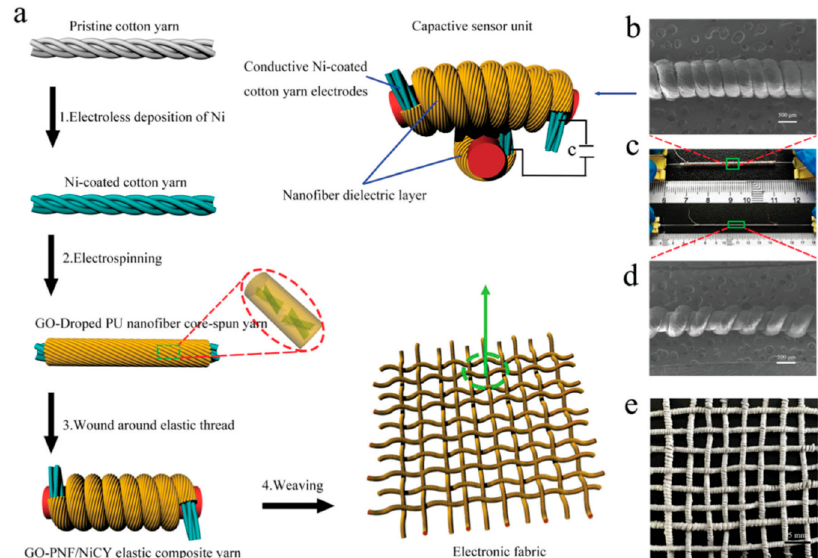
Figure 6. ( a ) Schematic demonstrating the use of yarns for developing electronic fabrics. Briefly, graphene doped polyurethane fibers are deposited on the surface of Ni-coated cotton yarns. These core-shell yarns are then wound around an elastic thread. In the next step, the composite yarns are woven to obtain a fabric. ( b ) SEM image of the elastic composite yarn. ( c ) optical microscopy image of the elastic composite yarn. ( d ) SEM image of the stretched elastic composite yarn. ( e ) optical microscopy image of the woven electronic fabric. Reprinted from Journal of Materials Chemistry C , Vol. 6,